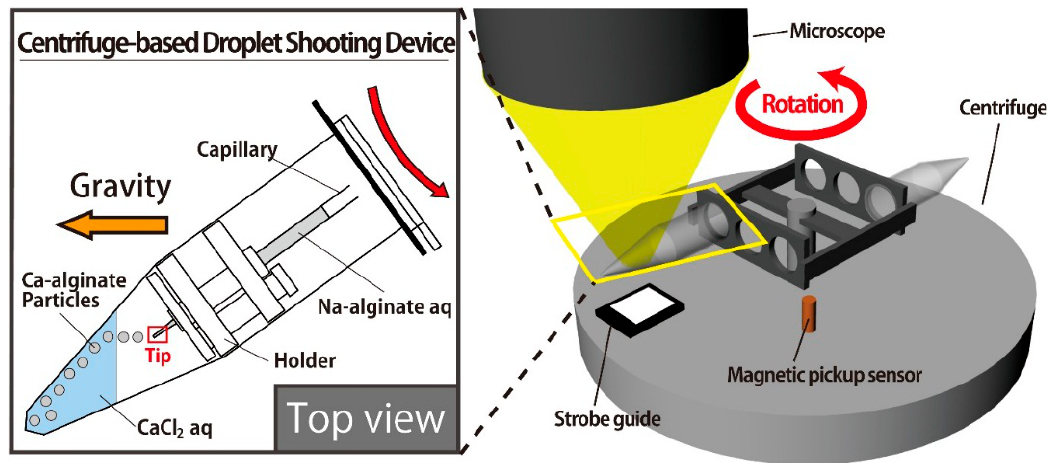
Figure 1. Schematic depiction of the setup for observation of the capillary jet.